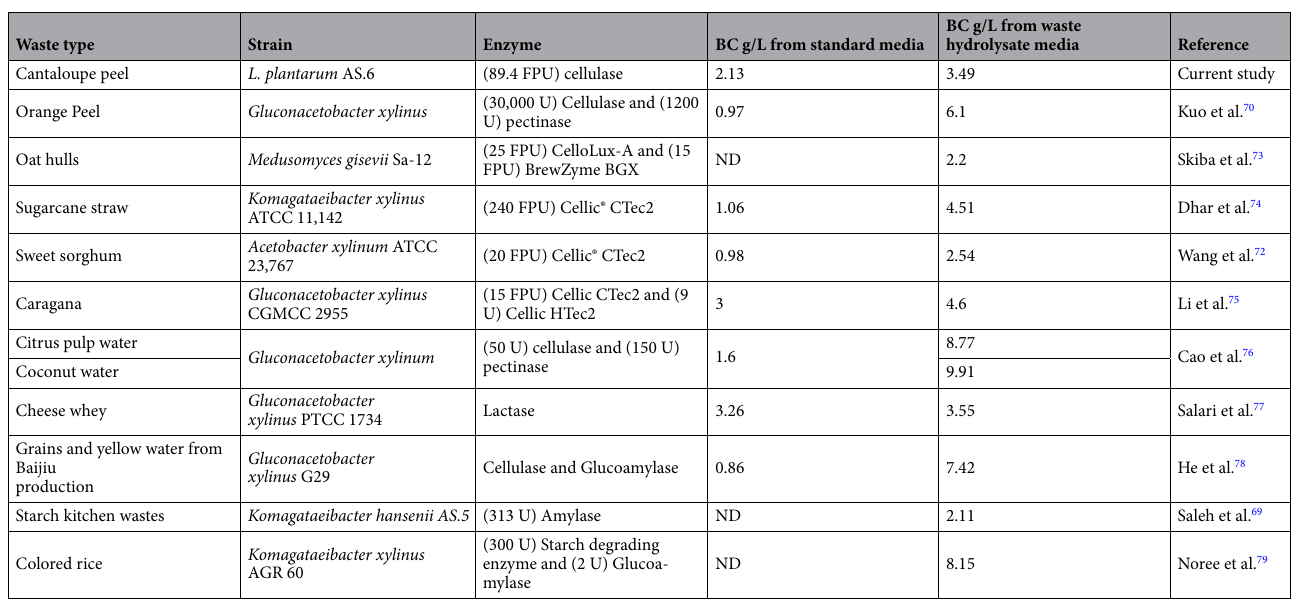
Table 1. Comparison of BC production using enzymatic hydrolysis of different